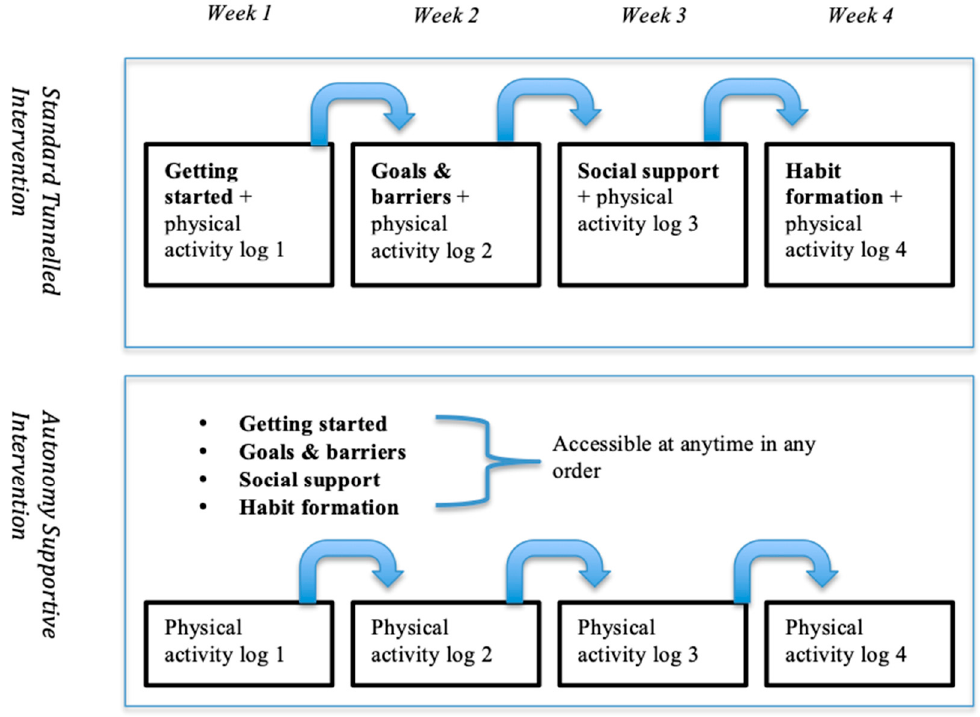
Figure 1. Tunneled intervention ( top ) and free-choice website intervention ( bottom ) architecture. The physical activity log (assessing activity in last week) was also available to complete at any time in the free-choice architecture condition, with a new one unlocking a week after the first one was completed.